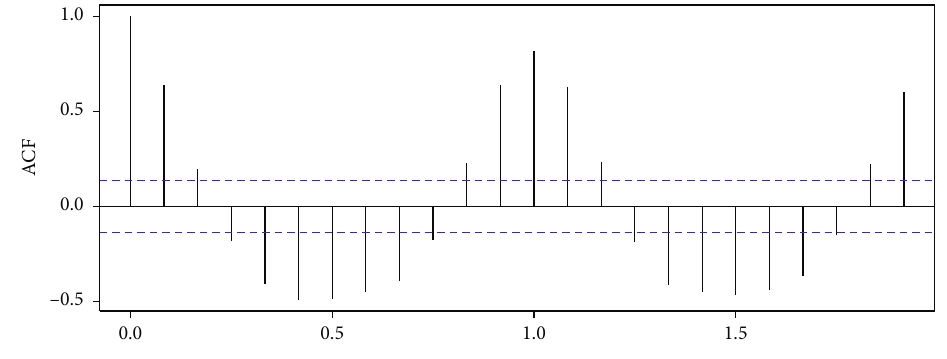
0.5 1.0 Figure 8: The autocorrelation diagram of SCST in region 13 (ACF).